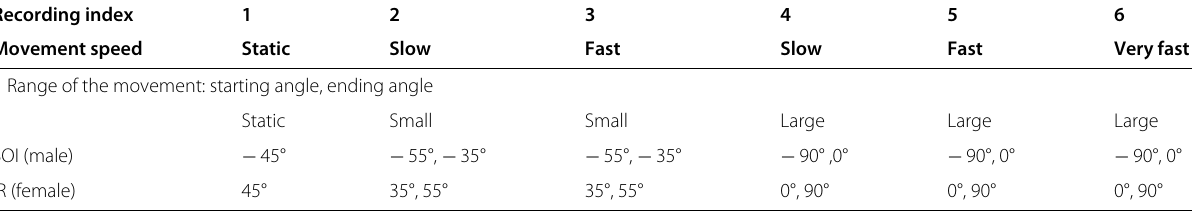
Table 3 Angular intervals and speed of SOI and IR movements in experiment 4.2